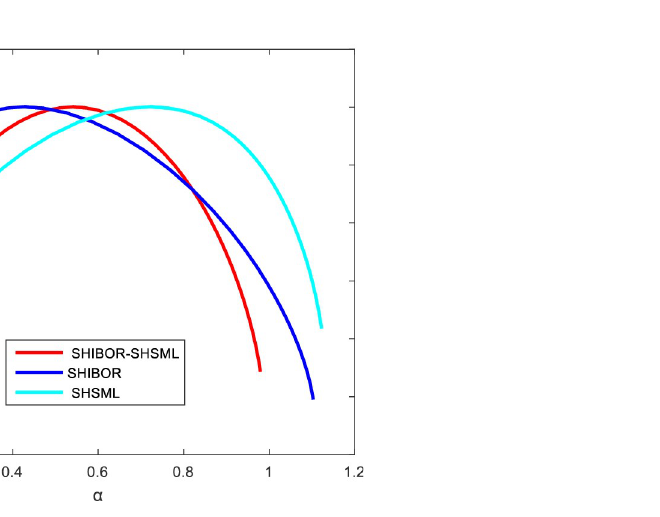
Fig 7. The multifractal spectra for series of SHIBOR and SHSML.